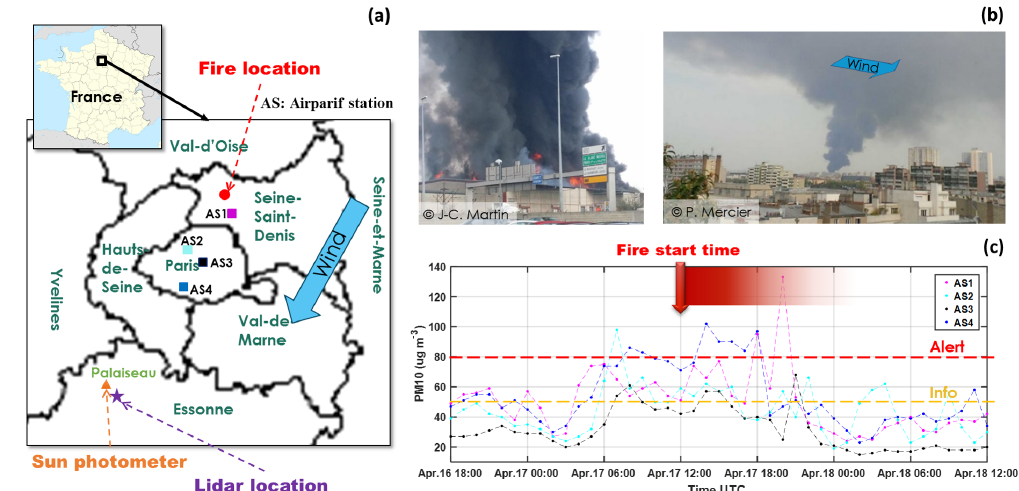
Figure 1. (a) Locations of the textile warehouse on fire (red circle), of lidar instruments (purple star), and of the sun photometer (orange triangle); (b) photo of the smoke plume from near (left) and far (right) distance; (c) in situ measurements of PM 10 from four Airparif stations (locations shown in a ). The alert and information values are also given by the red and yellow dashed